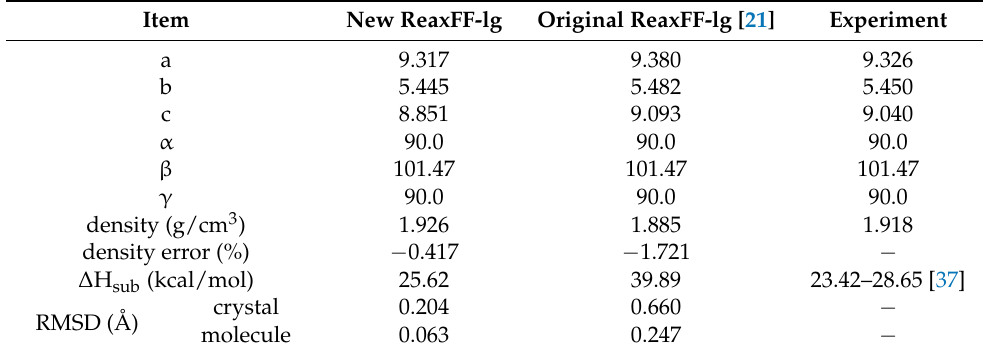
Table 1. The lattice constants, density, heat of sublimation, and root-mean-square deviations of β